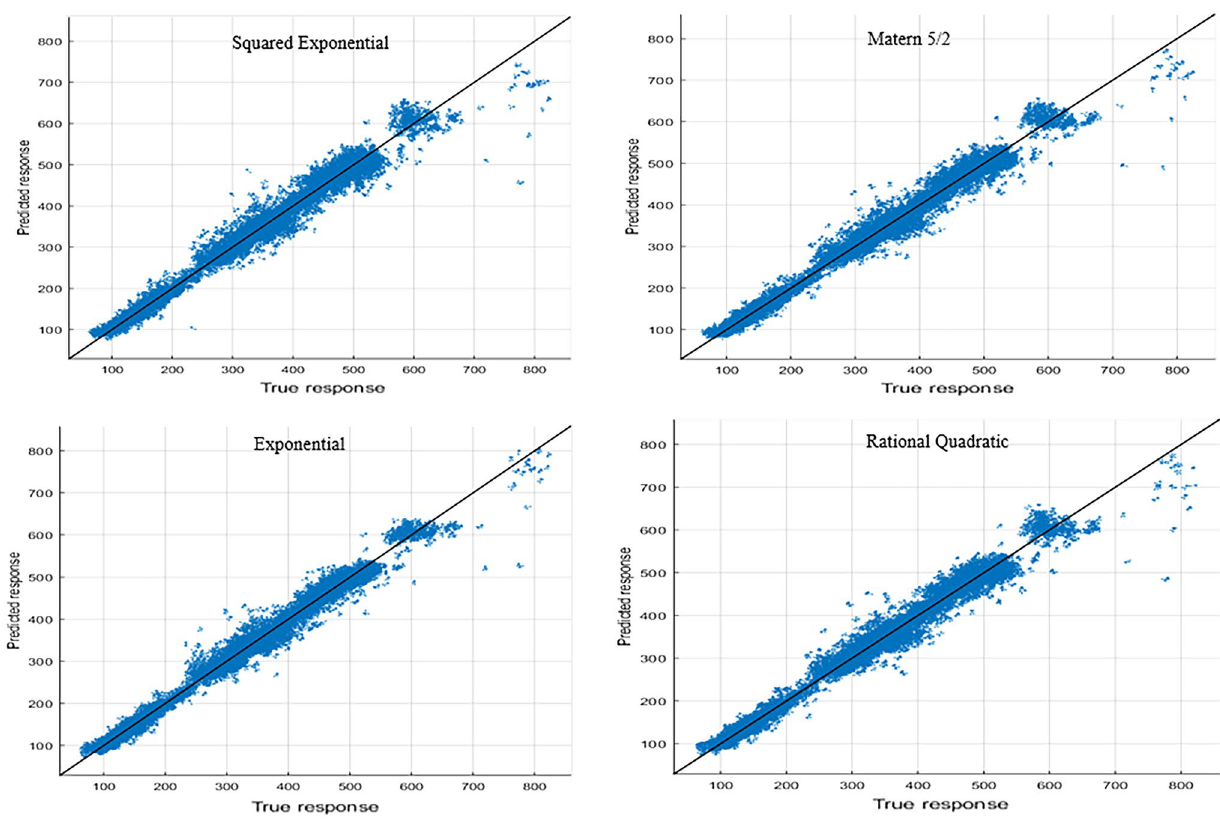
Fig. 5 Cross-plot of the tested GP